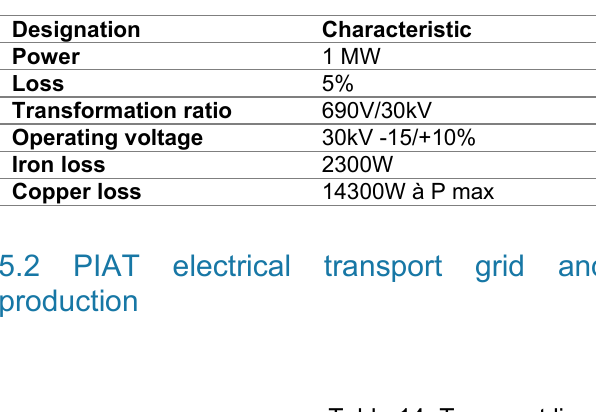
Table 14. Transport lines and transformer stations